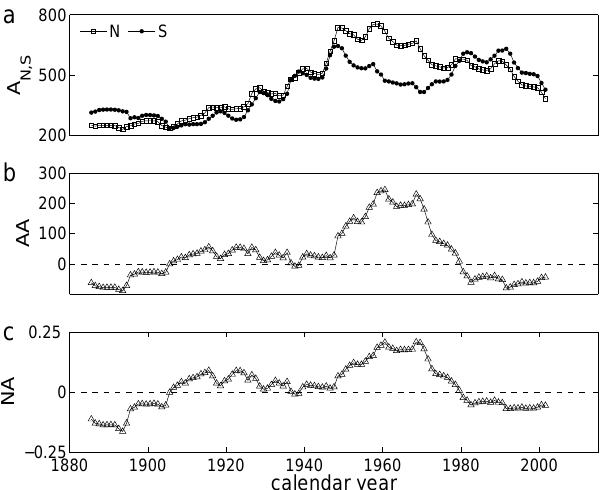
Figure 2. Average monthly hemispheric sunspot areas A N , S (a) , ab- solute (AA) (b) and normalized area difference (NA) (c) for running windows with a width of w = 270 months and a mutual overlap of 12 months. Note that (a) differs from Fig. 1 only by the longer av- eraging window.